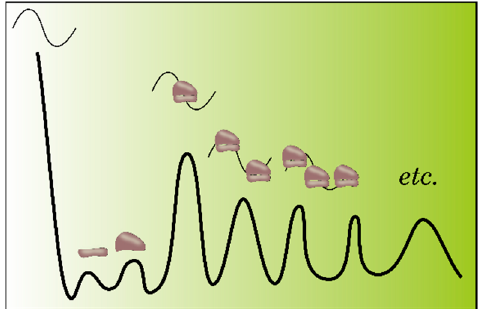
Figure 1. Polysome profiling in a sucrose density gradient. Separation of the transcripts depending on the ribosome loading: the first peak corresponds to the mRNAs unbound to ribosomes; second and third peaks, to the ribosome small and large subunits, respectively; and the fourth and subsequent peaks, to the mRNAs with different ribosome loadings.